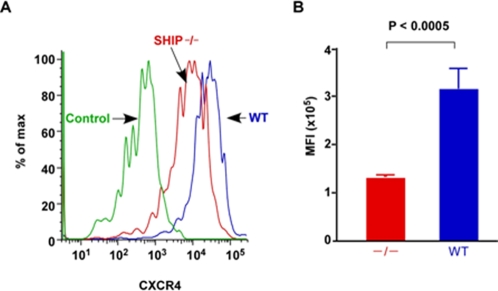
SHIP−/− MK have lowered CXCR-4 receptor expression.(A) Histogram representing the level of CXCR-4 receptor expression on SHIP−/− (black line) and WT (gray line) Lin−c-kit−CD41+ cells in BM. Isotype antibody control indicated in the histogram. (B) Represented is the mean±SEM of the mean fluorescence (MFI) intensity of CXCR-4 expression on SHIP−/− (−/−) (n = 4) and WT (n = 4) Lin−c-kit−CD41+ in BM. Significance was established using the Mann-Whitney test. p values indicated in each graph.